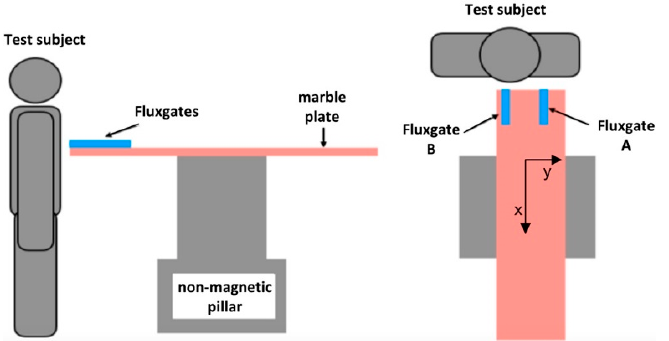
Figure 4. The schematic diagram of MCG measurements based on fluxgate magnetometers.